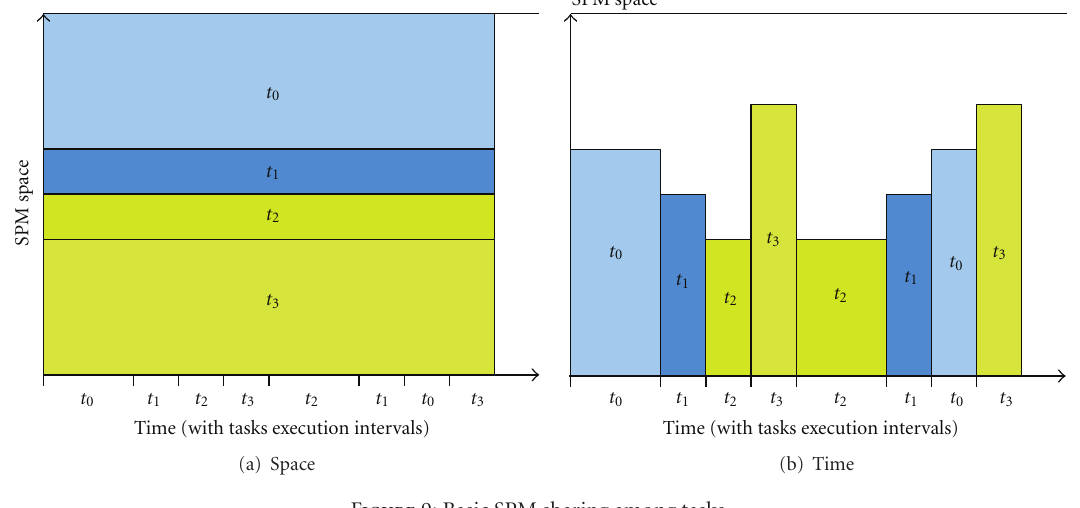
Figure 9: Basic SPM sharing among